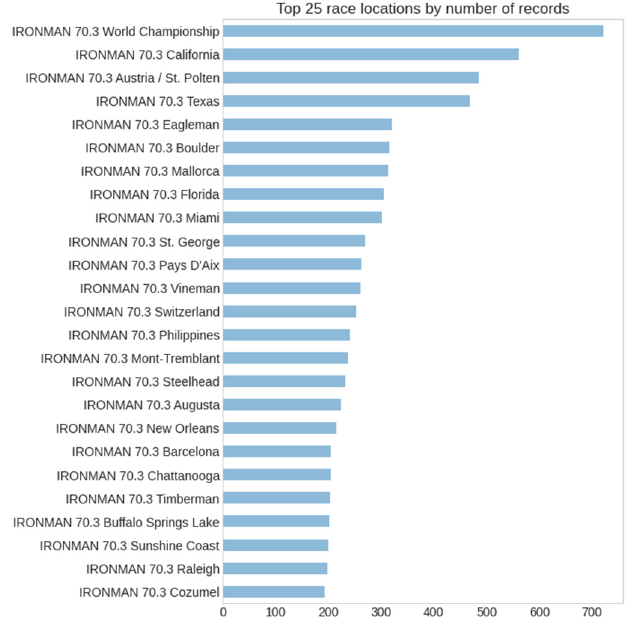
Figure 6. Top 10 locations by number of records.